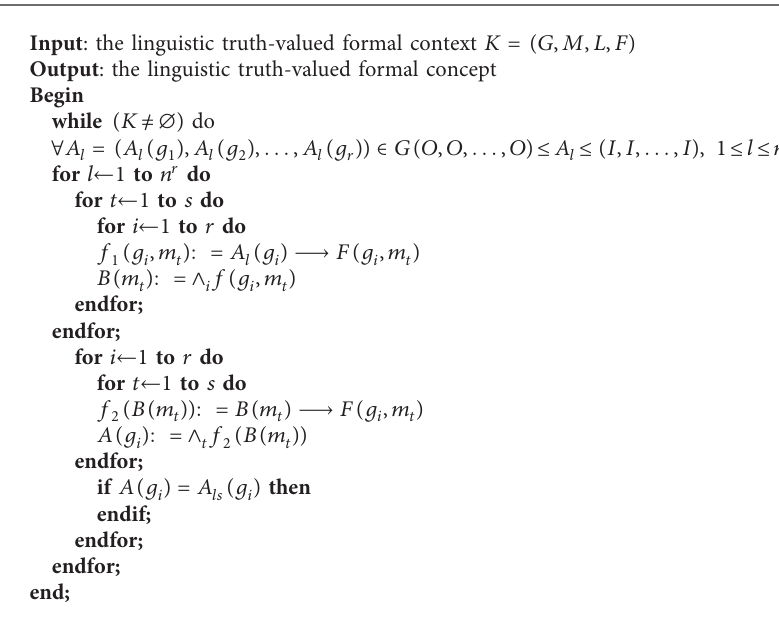
Table 5: The LTV-formal context K